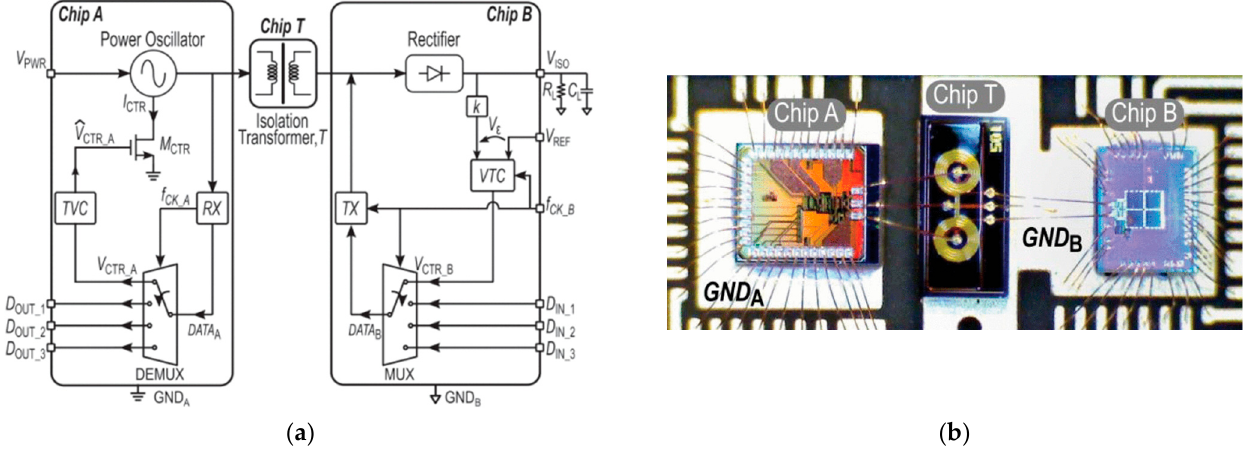
Figure 10. Single-transformer DC–DC converter with bidirectional data communication ( a ) Block diagram. ( b ) Micro- graph. Reproduced from [21]. Copyright 2016, IEEE.